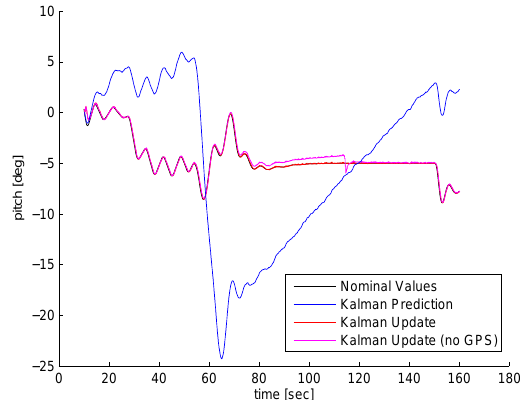
Figure 8: Pitch angle estimation (Roma Sequence). Nominal value (black line), Kalman Prediction without GPS (blue line), Kalman Update (red line), Kalman Update without GPS (ma- genta line).